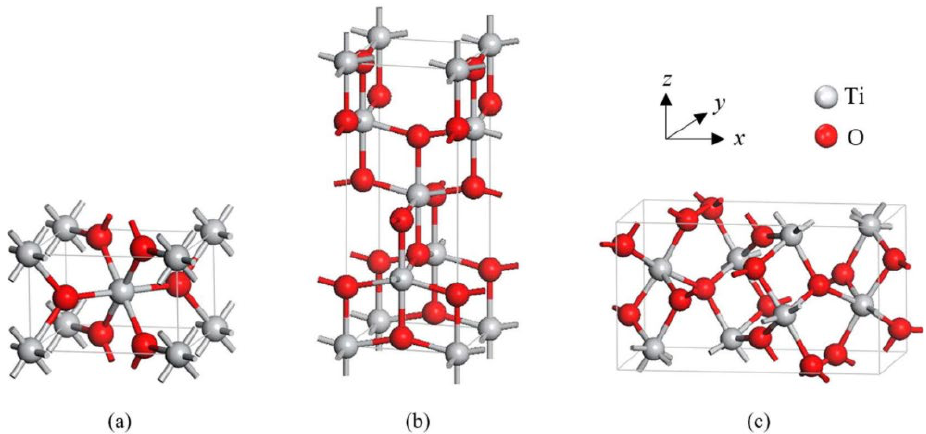
Figure 2. Tetragonal structures of crystalline forms of ( a ) rutile and ( b ) anatase, and orthorhombic structure of ( c ) brookite TiO 2 . Reprinted from [6].